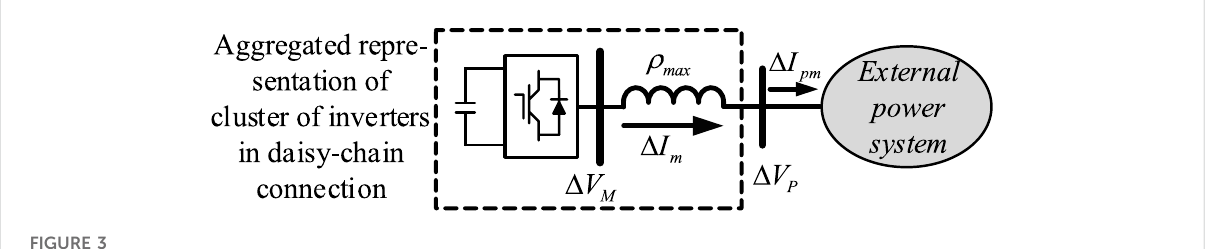
FIGURE 3 Aggregated representation for studying oscillatory stability of a cluster of similar inverters in a daisy-chain